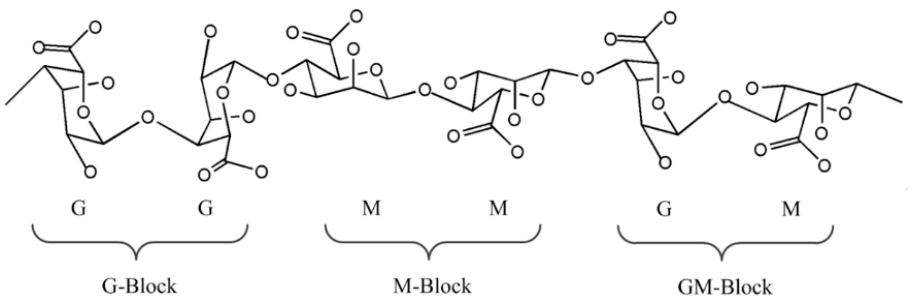
Figure 1. Structure of sodium alginate [27].